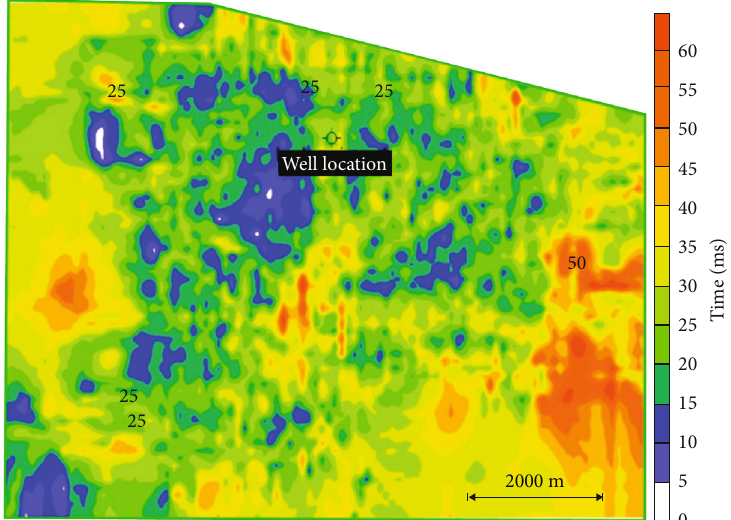
Figure 13: Averaged temporal thickness distribution of the low frequency anomaly (the Pas łę k Formation) interpreted with the use of the CEEMD, IF, and FFT